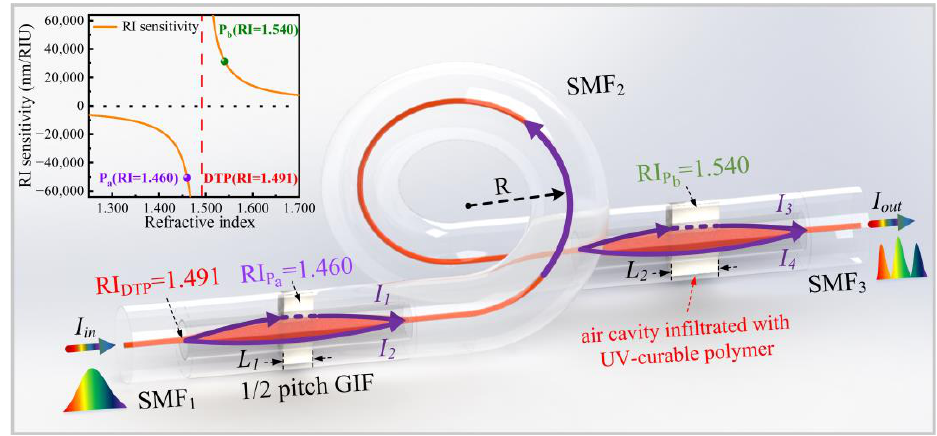
Figure 2. Schematic diagram of the proposed highly sensitive temperature sensor based on cascaded polymer-infiltrated MZIs operating near the DTP. (Inset: the calculated RI sensitivities of the MZI infiltrated with polymers with different RIs).